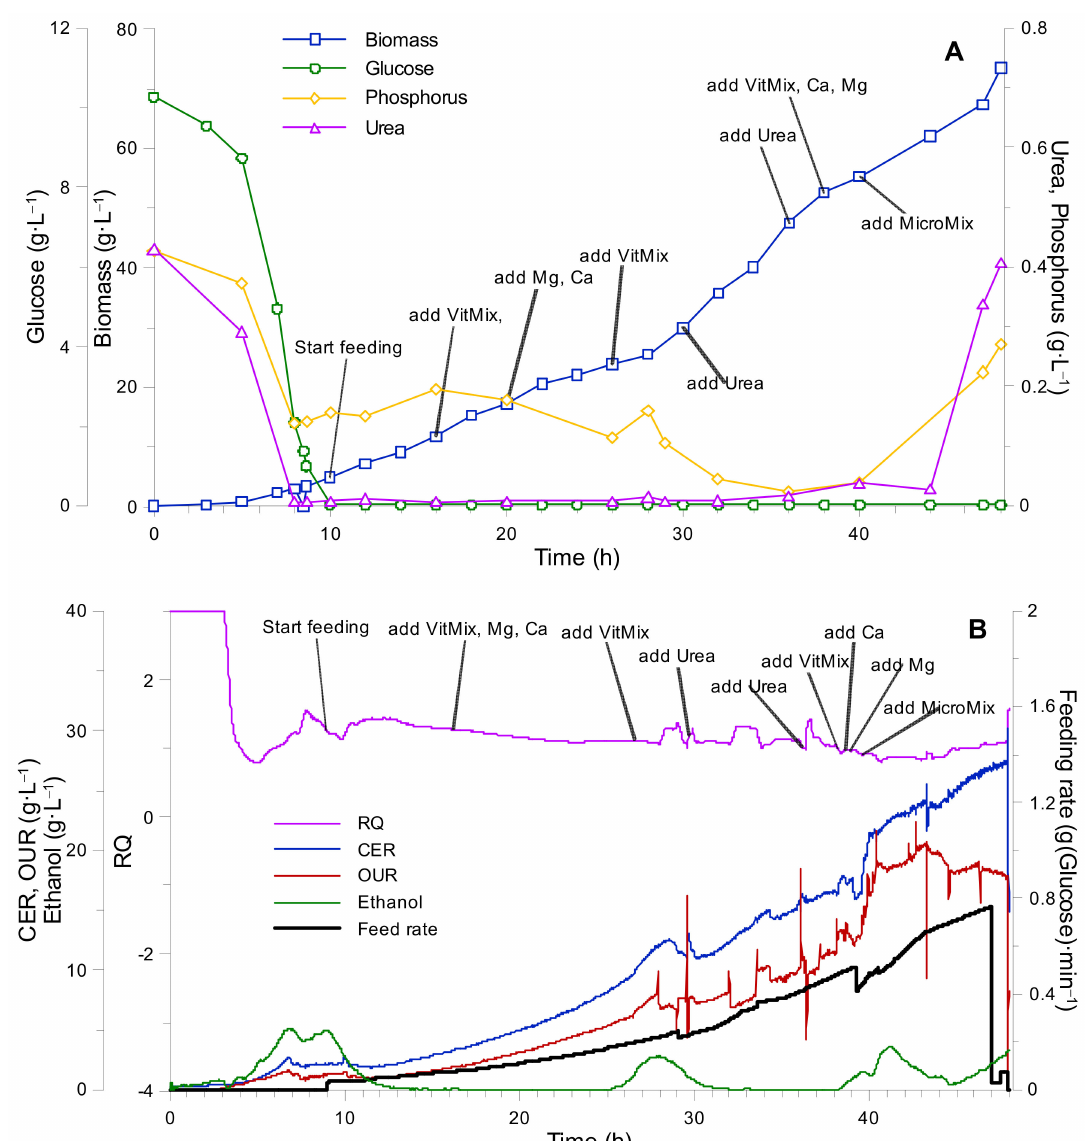
Figure 6. K. marxianus bioreactor cultivation 3. process. ( A ) Biomass growth and cultivation medium component (glucose, urea, phosphorus) uptake curves. ( B ) Gas analysis data (RQ—respiratory quotient, CER—carbon evolution rate, OUR— oxygen uptake rate, ethanol concentration, and feeding